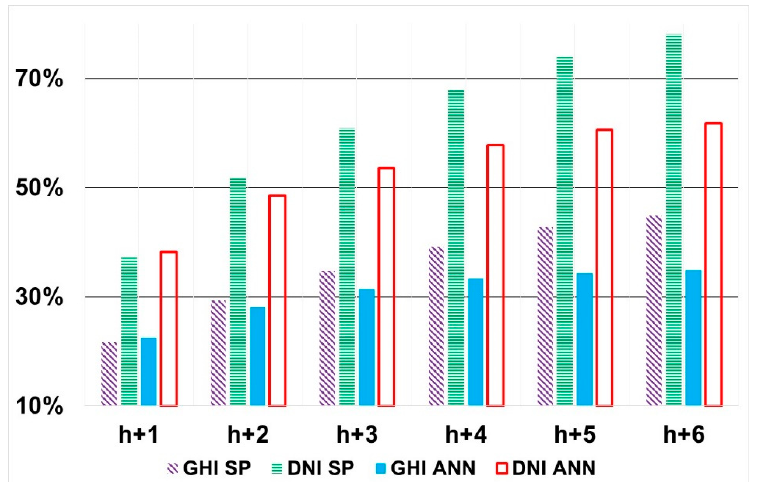
Figure 12. Comparison of forecasting models for GHI and DNI in terms of nRMSE (Odeillo site). As previously underlined, GHI was forecasted with a better accuracy compared with